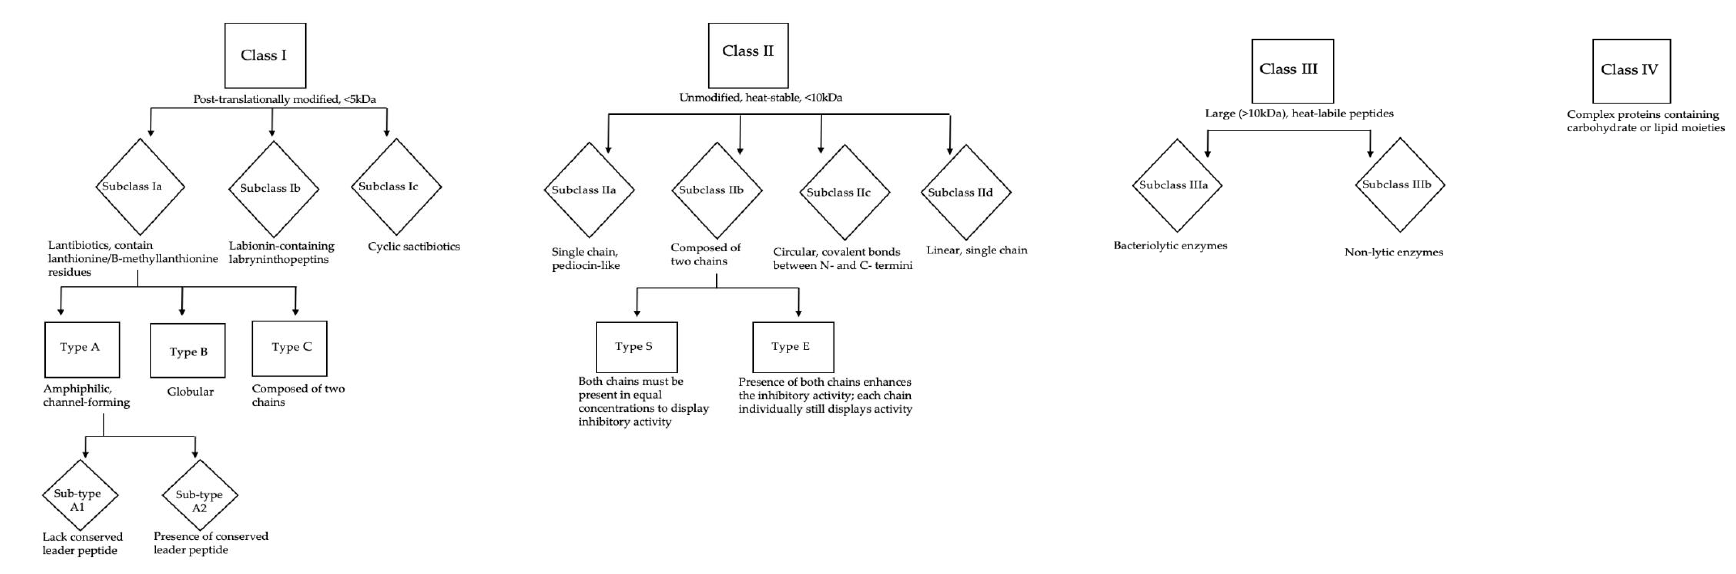
Figure 1. Classification of Gram positive-derived bacteriocins.